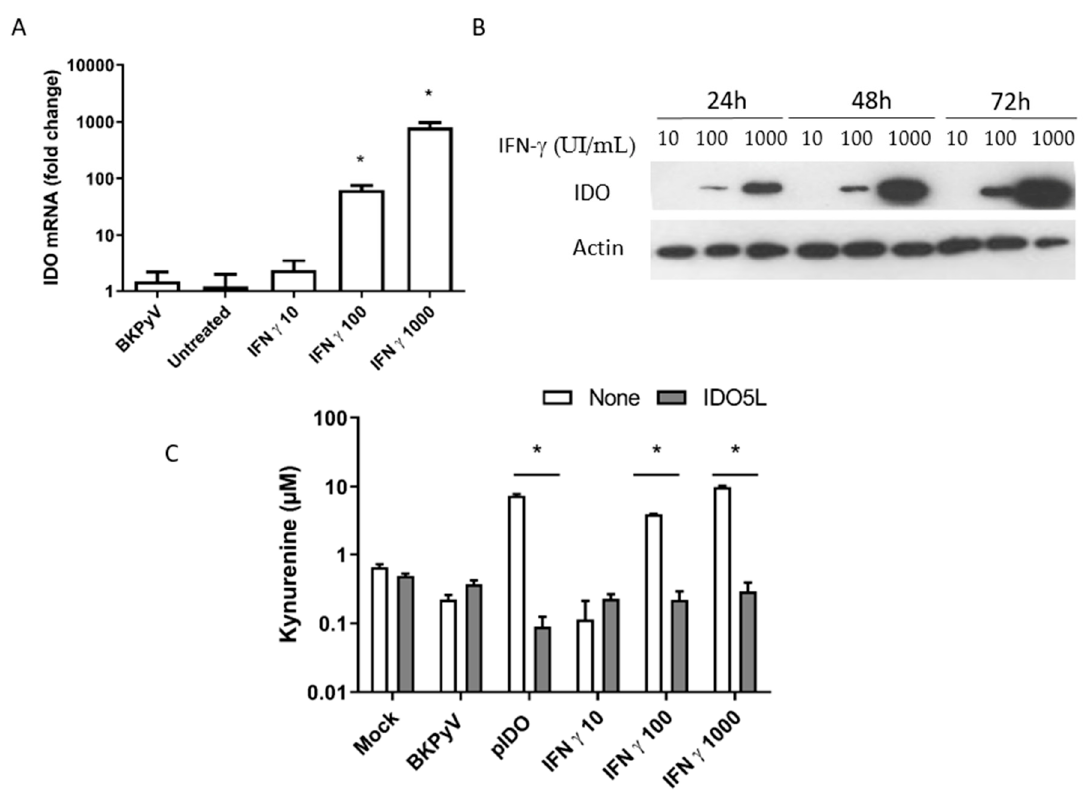
Figure 4. IFN-gamma promotes the over-expression of functionally active indoleamine 2,3-dioxygenase (IDO) in Caki-1 cells. ( A ) Caki cells were treated with IFN-gamma or transfected with a plasmid carrying the human IDO1 gene. Three days after IFN treatment or transfection, the level of IDO1 mRNA was measured using a quantitative RT-PCR assay. ( B ) For IDO protein expression, proteins were collected 24, 48 or 72 h after IFN treatment. The Western blot shows the IDO expression after treatment with 10, 100 or 1000 IU / mL of IFN. The results in A and C represent the mean ± SD of three independent experiments performed in triplicate. “Mock” corresponds to non-infected cells and “Untreated” corresponds to cells infected in the absence of IFN. * p < 0.05. ( C ) IDO’s functional activity and its inhibition by IDO5L at 50 µM were determined by measuring kynurenine accumulation in Ehrlich’s colorimetric reaction.